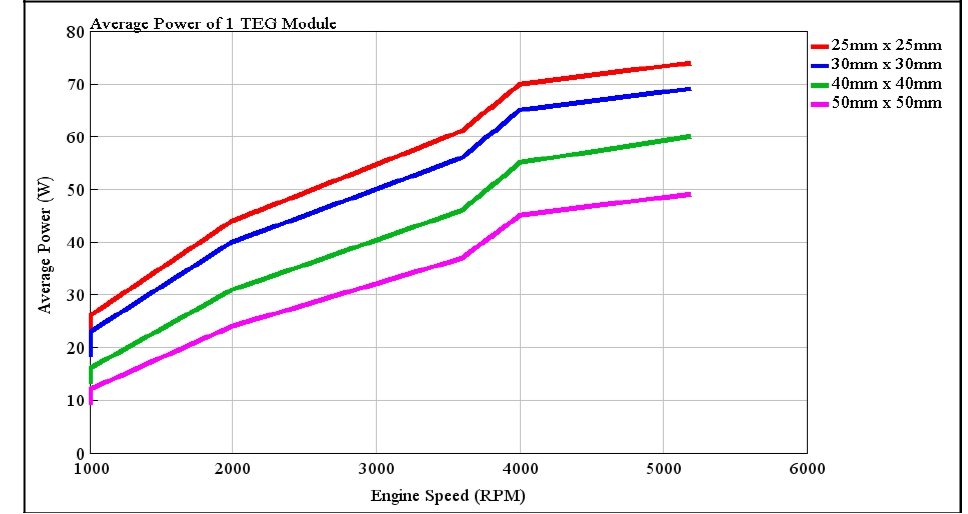
Figure 16. Power generated by different module size (1 module).